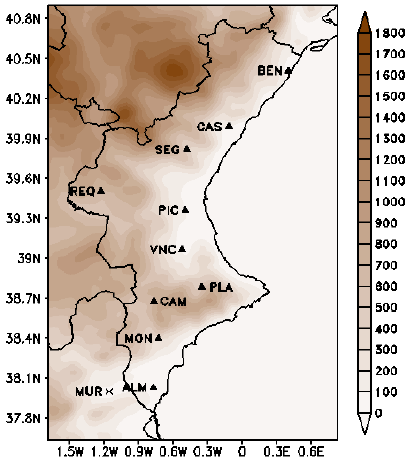
Figure 1. RAMS orography (m) on domain D3 and surface (closed triangle) and sounding (multiplication sign) weather station locations.